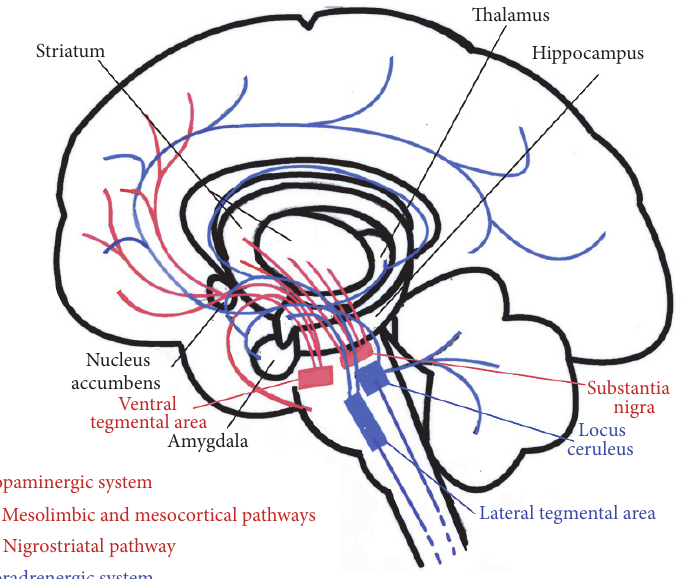
Figure 1: Dopaminergic and noradrenergic ascending pathways. This figure was drawn by the authors from information taken from texts and figures in literature